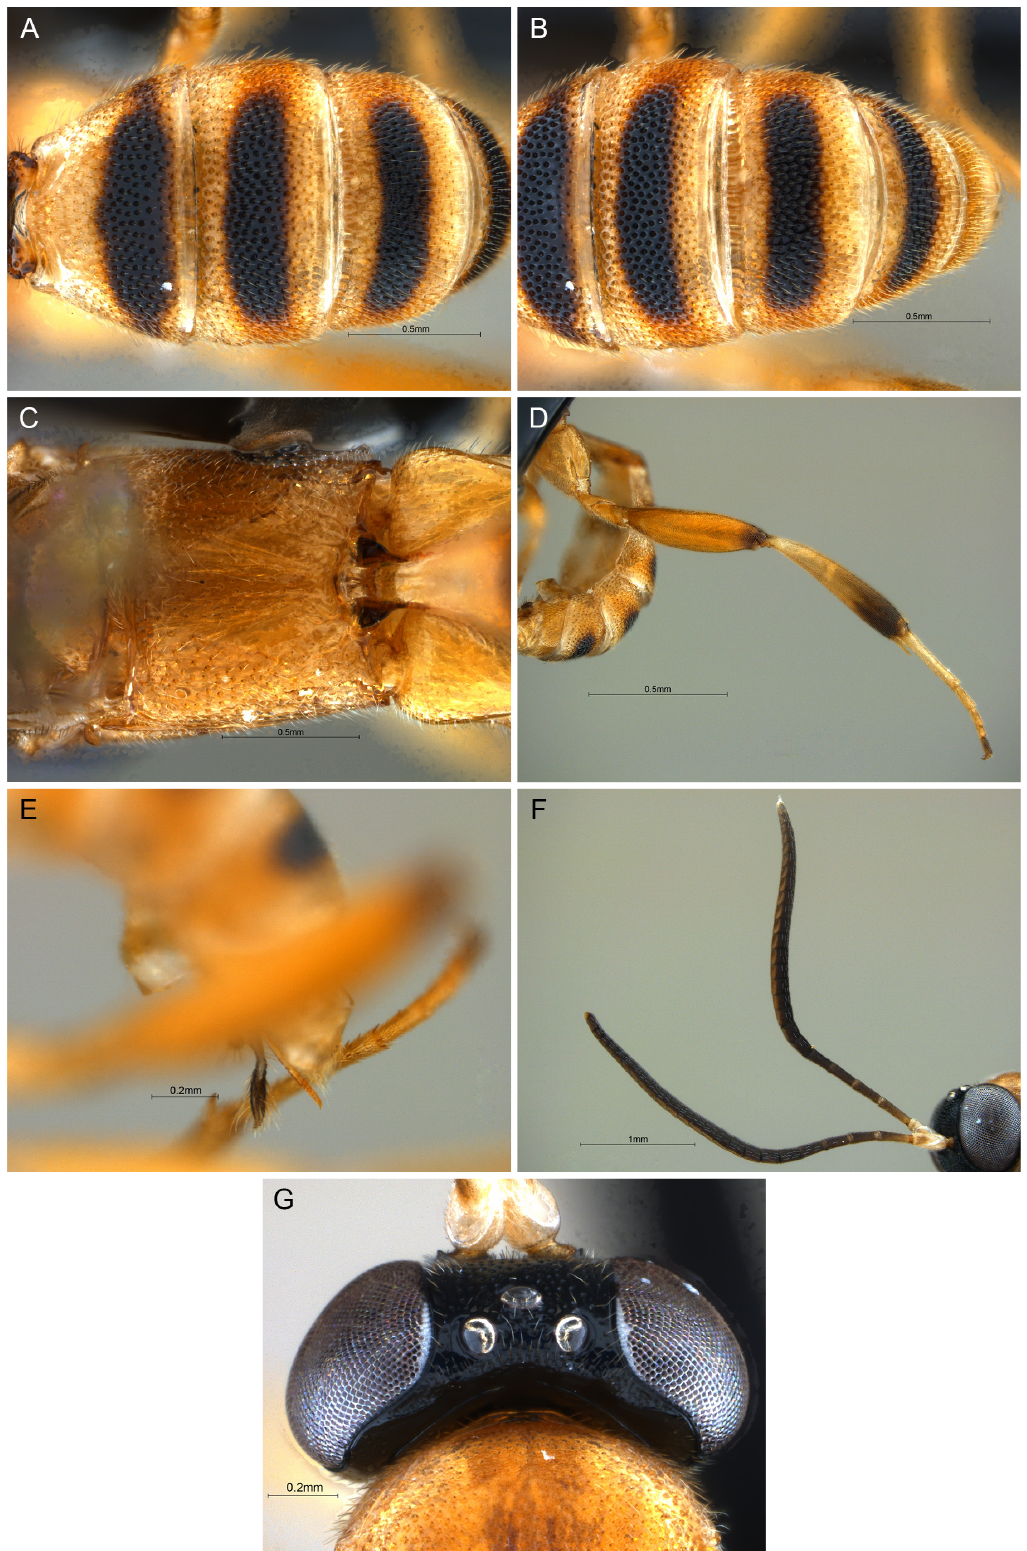
Fig. 8. Palpostilpnus angka sp. nov., holotype, ♀ (QSBG 2014-242). A . T2–T4, dorsal view. B . T4–T5, dorsal view. C . Propodeum, dorsal view. D . Hind leg. E . Ovipositor. F . Antennae. G .